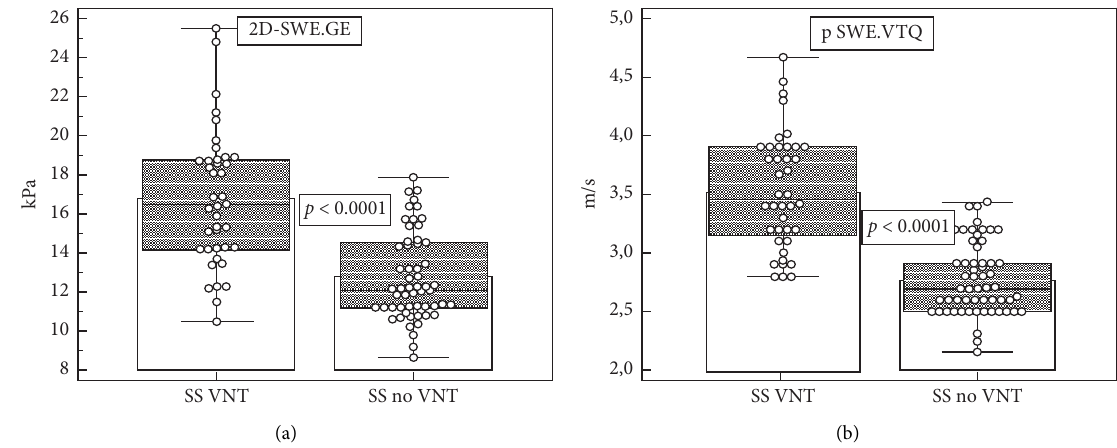
Figure 2: Comparison of mean SS by 2D-SWE.GE and pSWE.VTQ values in patients with VNT versus patients with no